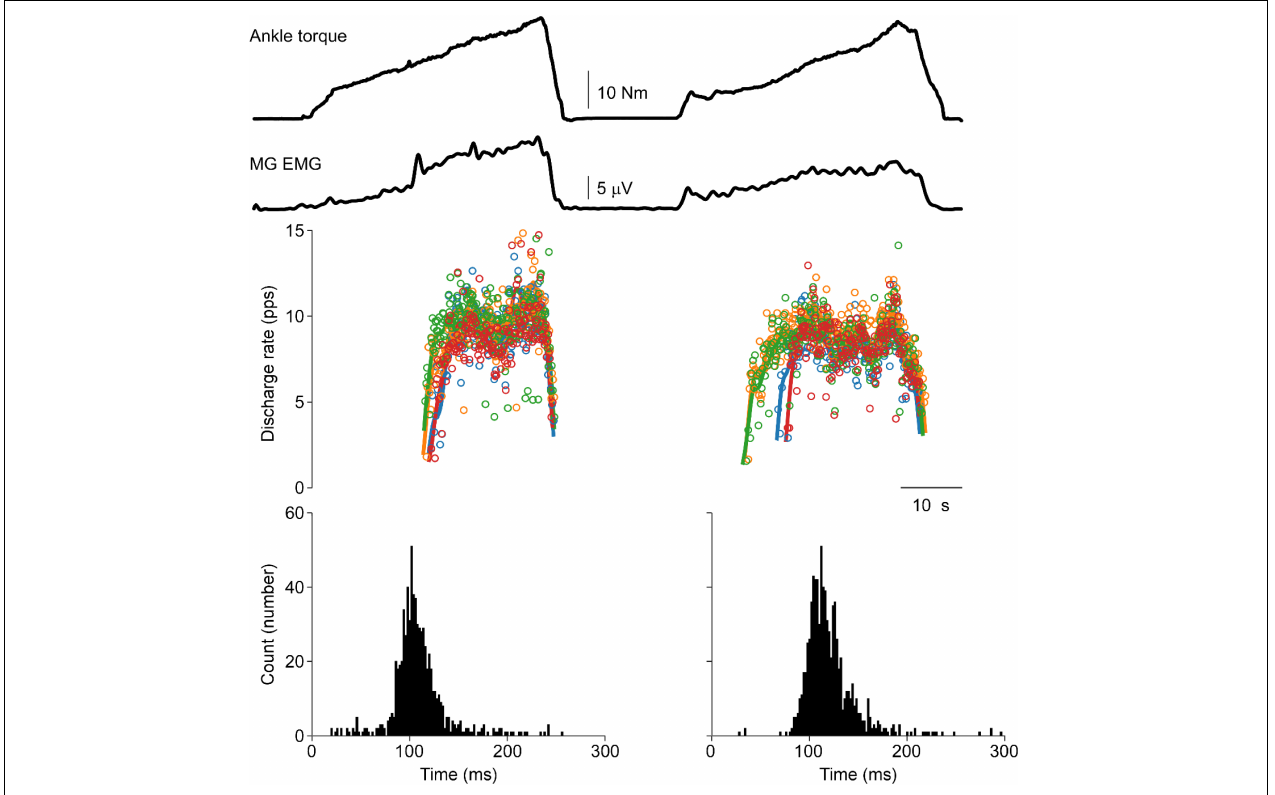
FIGURE 5 | Vibration evoked and matched volitional contractions in the human. Representative data from a single human participant. The first contraction is elicited by vibration of the triceps surae tendon, whereas the second contraction is a volitional contraction set to match the EMG profile of the vibration evoked contraction. Similar motor unit discharge patterns are observed in both contractions. No punctuation is observed during the vibration evoked contraction with ASD values of 0.36 and 0.32 during vibration-evoked and volitional contractions, respectively. A distance of 0.28 is observed between these cISI histograms.